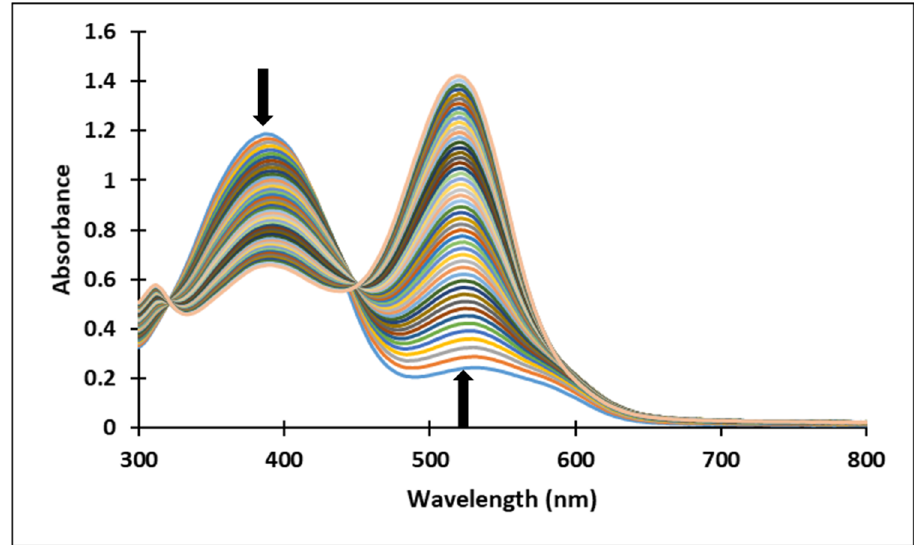
Figure 11. Spectral variations after direct pH-jump of solution of compound 4 , from pH 12.17 to pH 0.12.